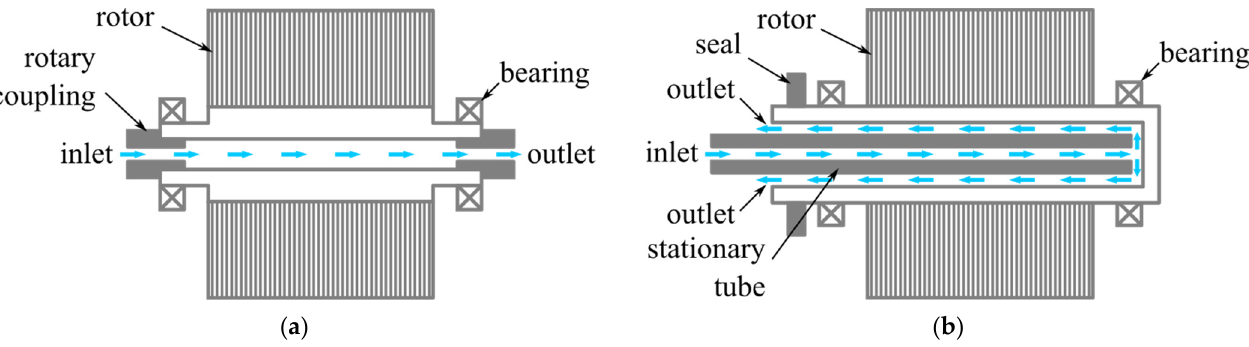
Figure 18. Hollow shaft oil-cooling method [107]: ( a ) hollow-shaft; ( b ) recirculating hollow-shaft structure.